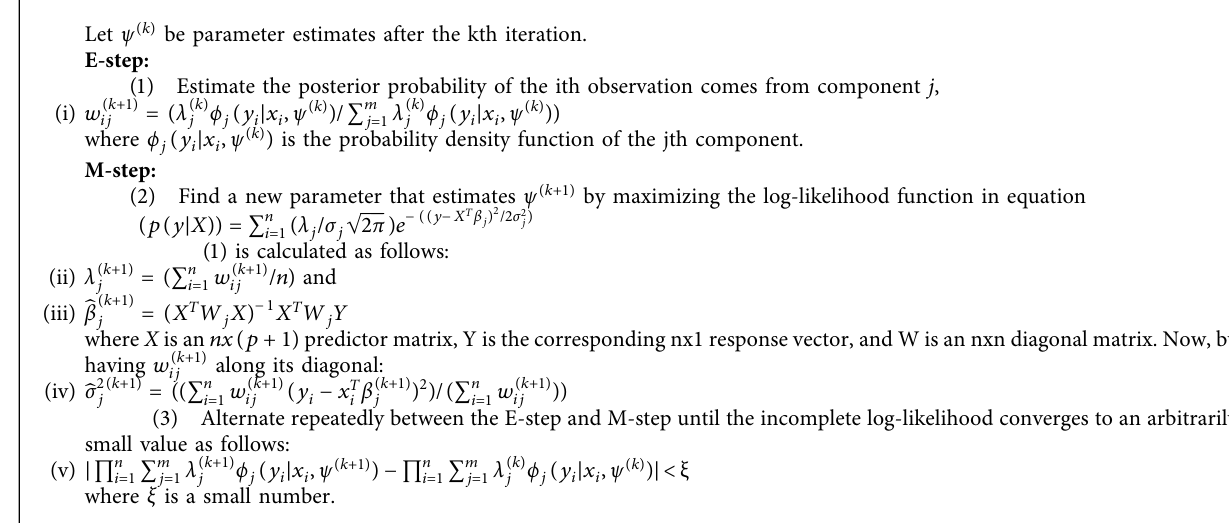
Let ψ ( k ) be parameter estimates after the kth